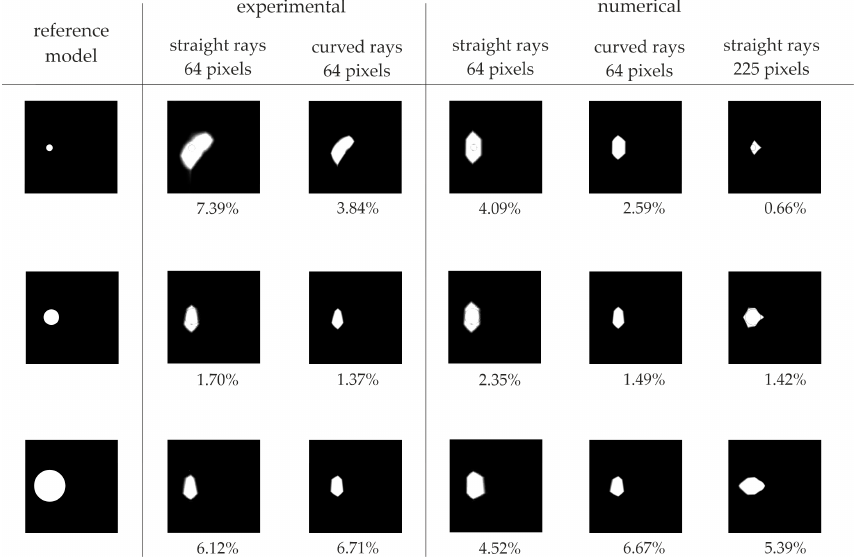
Figure 19. Error coefficient values for maps with reduced spectrum based on the travel time differ- ence method. ence